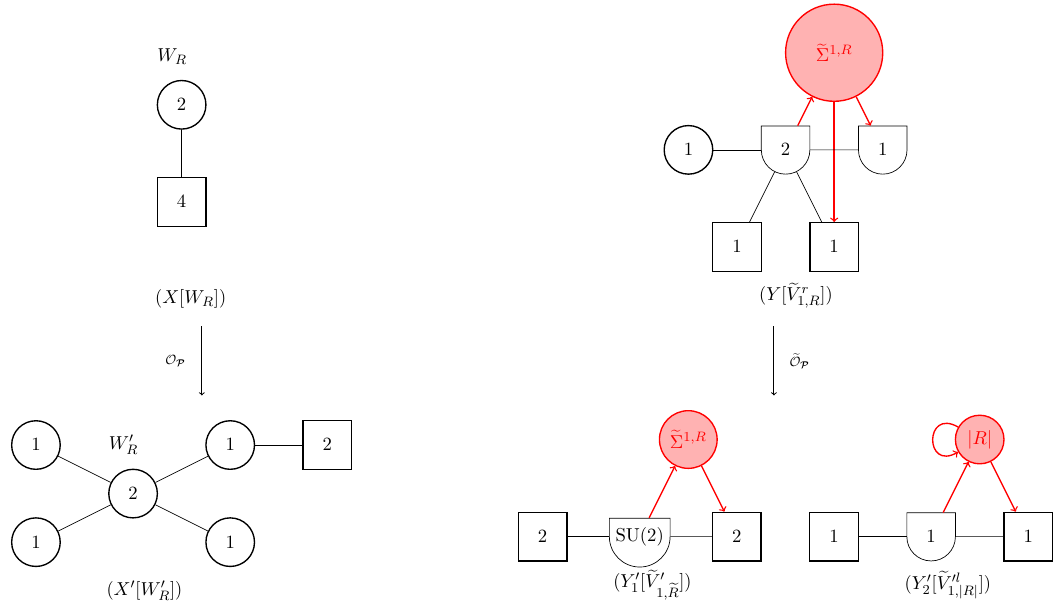
Figure 65 . Wilson defect in the central gauge node of the b D 4 quiver X 0 , and the dual vortex defect Y 0